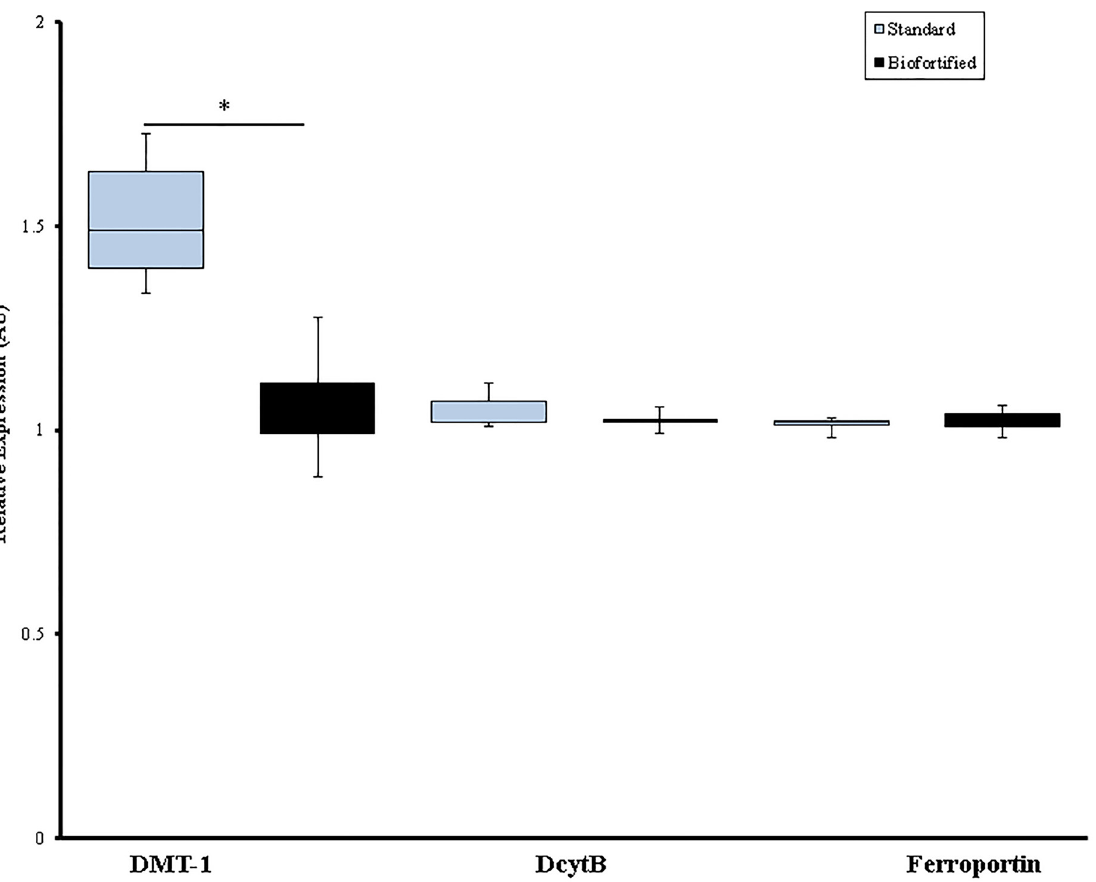
Fig 2. Duodenal mRNA gene expression of Fe-related proteins collected on day 42 1 . 1 Changes in mRNA expression are shown relative to expression of 18S rRNA in arbitrary units (AU, * P < 0.05).